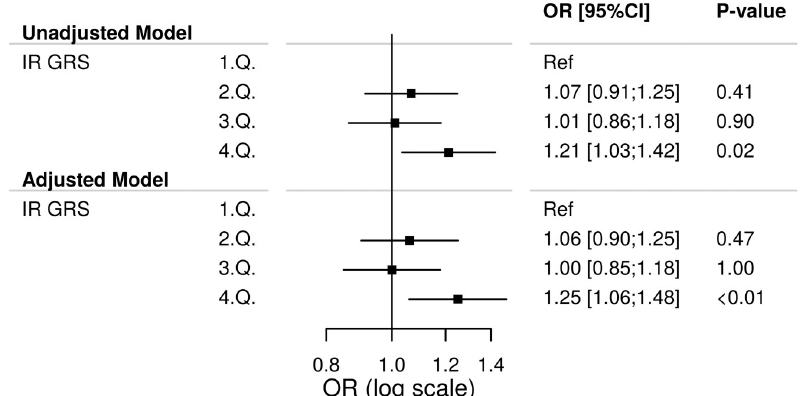
Fig 1. Association of the unweighted insulin resistance genetic risk score (IR GRS) with the risk of coronary artery disease among 4963 patients referred for coronary angiography. Logistic regression was used for this analysis. 1. Q, ... ,4.Q: 1. Quartile, ... ,4. Quartile. Ref: Reference. The Adjusted Model was adjusted for gender, age, smoking status and hypertension.